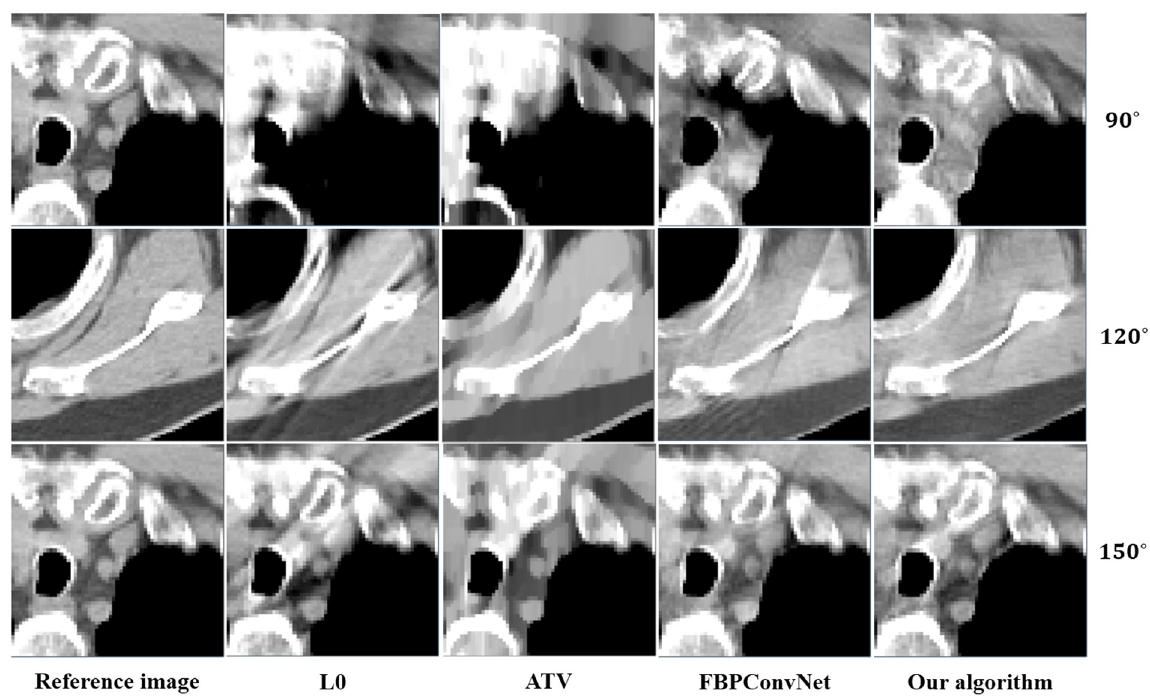
Fig 9. The zoom-in view of the ROIs for the Fig 7. The images on the first column are the ROIs of the reference image. The subsequent columns are the ROIs of the reconstructed image for L0 method, ATV method, FBPConvNet method and our algorithm.